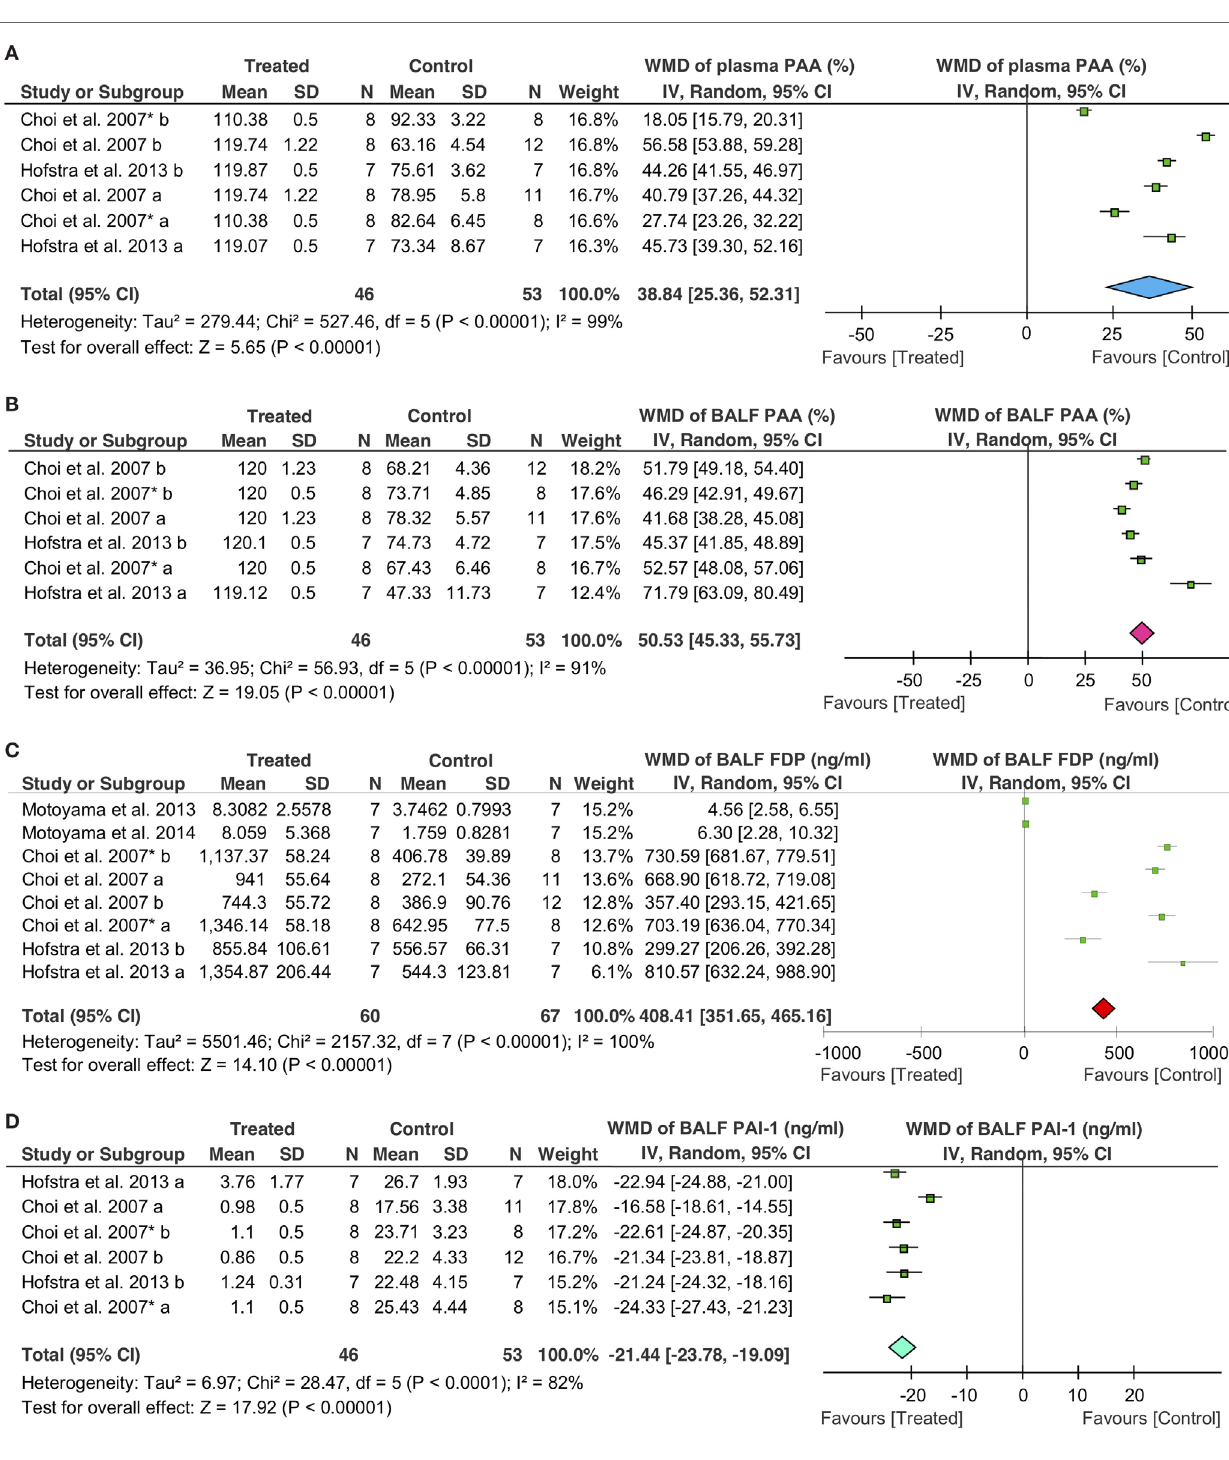
FiGURe 4 | Effects of fibrinolytic treatment on the fibrinolysis in the plasma and bronchoalveolar lavage fluid (BALF). (a) Plasma plasminogen activator activity (PAA). (B) BALF PAA. (c) BALF fibrin degradation products (FDP). (D) BALF plasminogen activator inhibitor type 1